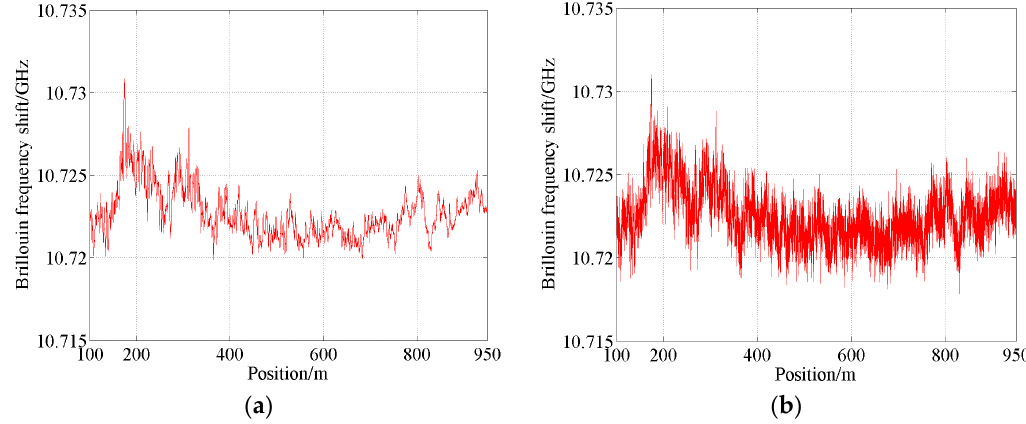
Figure 10. Changes of the extracted Brillouin frequency shift with fiber position. ( a ) Pulse width = 10 ns, average number = 2 18 ; ( b ) Pulse width = 10 ns, average number = 2 10 .